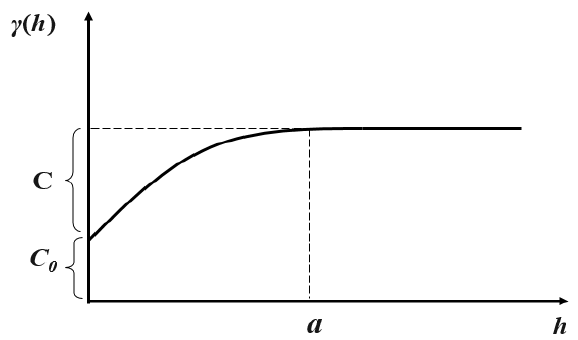
Figure 8. Variogram. Figure 8.